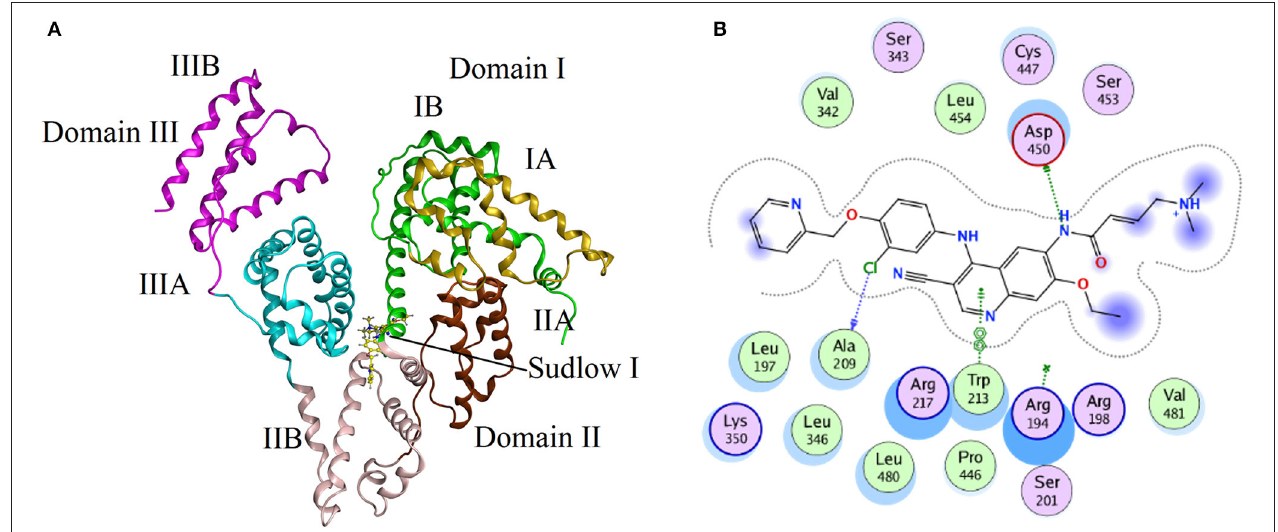
FIGURE 8 | (A) The docking conformation of neratinib-BSA complex with lowest energy; (B) Represents the amino acid residues that surround